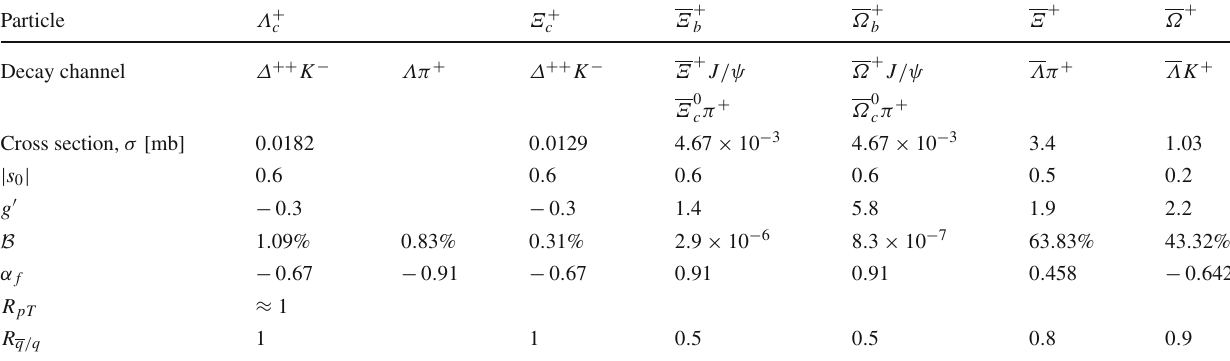
Table 3 Production cross sections σ , initial polarizations s 0 , nuclear modification factors R pT , and antibaryon-to-baryon ratios R q / q for √ p W collisions at s ≈ 115GeV, along with the anomalous magnetic moment g (cid:9) = ( g − 2 )/ 2, decay channels, branching ratios B and decay asymmetry parameters α f , for the different charm, beauty and strange charged baryons. For comparison purposes, the Λ + c case has been con-